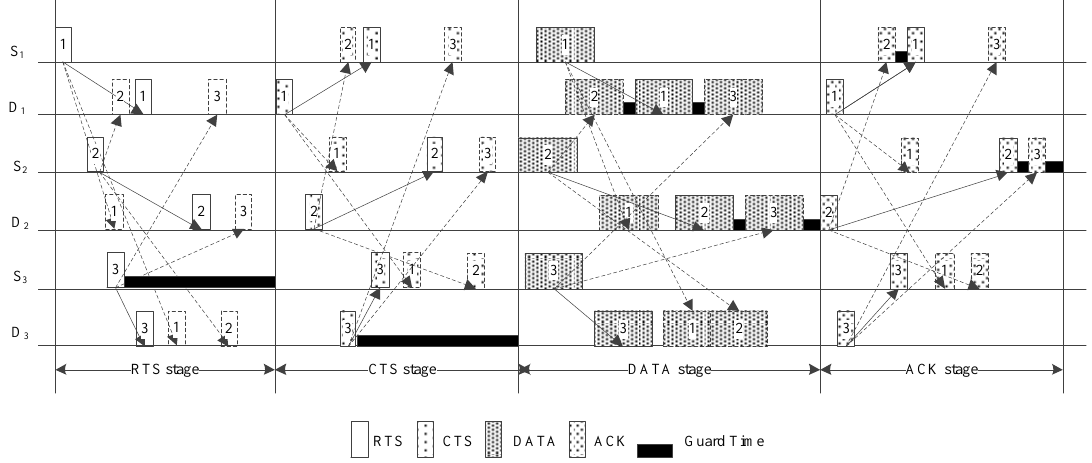
Figure 1. Timing diagram of the proposed protocol.